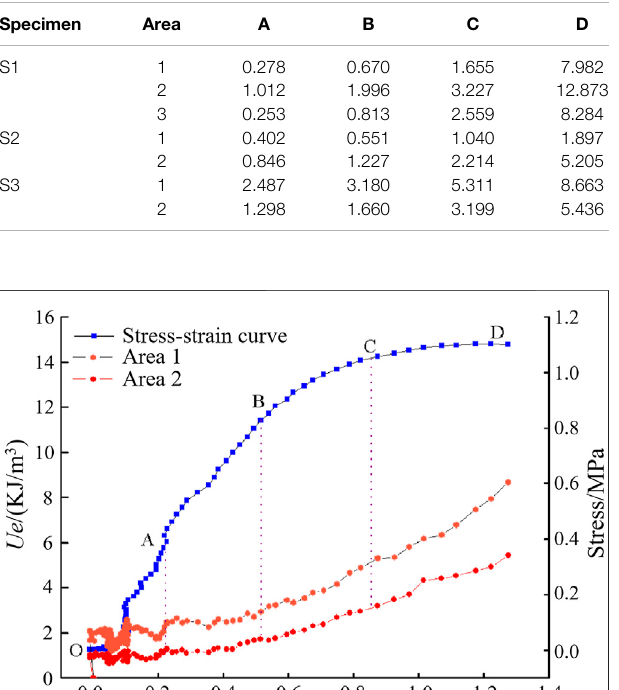
TABLE 3 | Elastic strain energy density in different specimen regions (kJ/m 3 ).